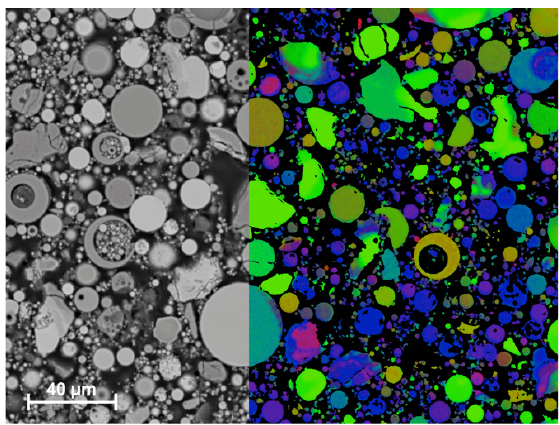
Figure 1. Image analysis based on BSE and EDX mapping data used to segment a class C fly ash in compositionally different populations. More Ca-rich fly ash particles (blue) are more reactive than Si-rich particles (green). Modified after [16].